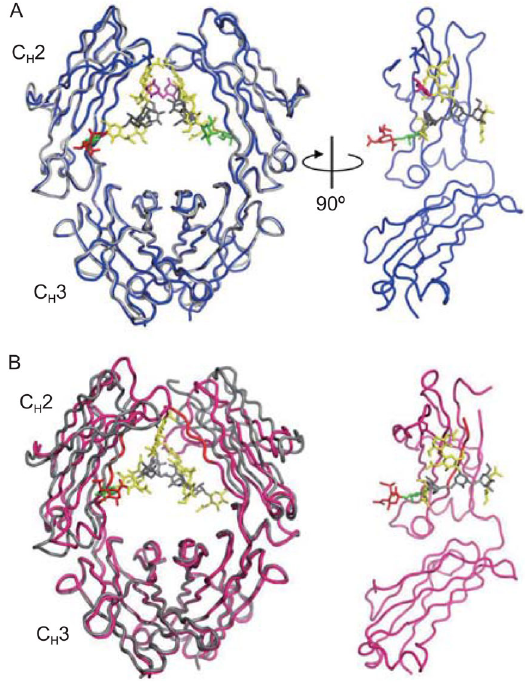
Figure 4. Comparison of sialylated and native Fc struc- tures. (A) Superposition of enzymatically sialylated Fc (blue) (PDB ID code: 4BYH) and native Fc (gray) (PDB ID code: 1H3Y). (B) Superposition of chemoenzymatically synthesized disialylated Fc (magenta) (PDB ID code: 4Q6Y) and native Fc (gray) (PDB ID code: 3AVE). The monosaccharides fucose, GlcNAc, mannose, galactose, and sialic acid are shown in magenta, yellow, gray, green and red, respectively. The molec- ular models were produced with PyMOL (The PyMOL Molecular Graphics System, Version 1.8.5.0,